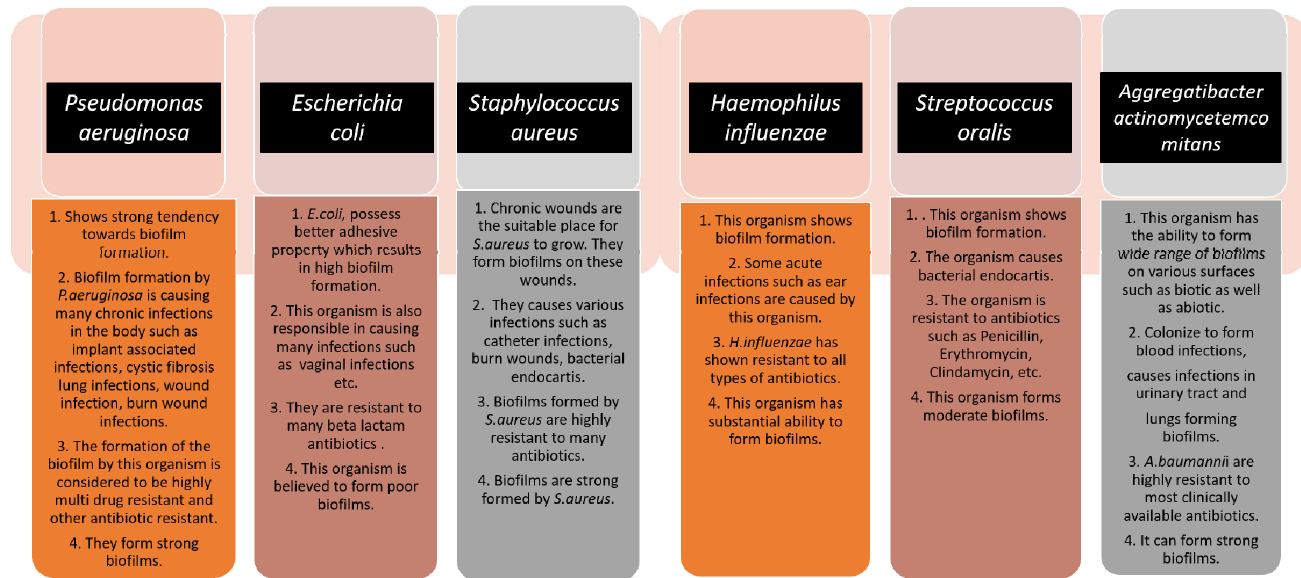
Figure 1. The schematic diagram highlights the characteristics of each microorganism in terms of biofilm formation and the diseases caused by them. The strength of the biofilm formation and antibiotic resistance are also mentioned.